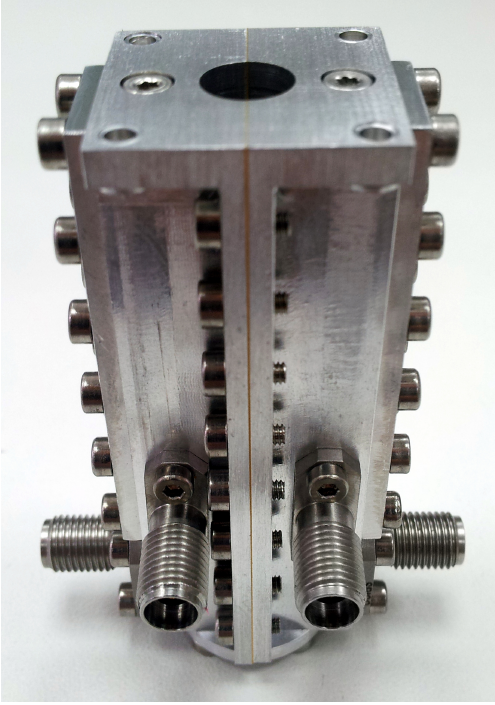
Figure 5. Ka-band septum polarizer and